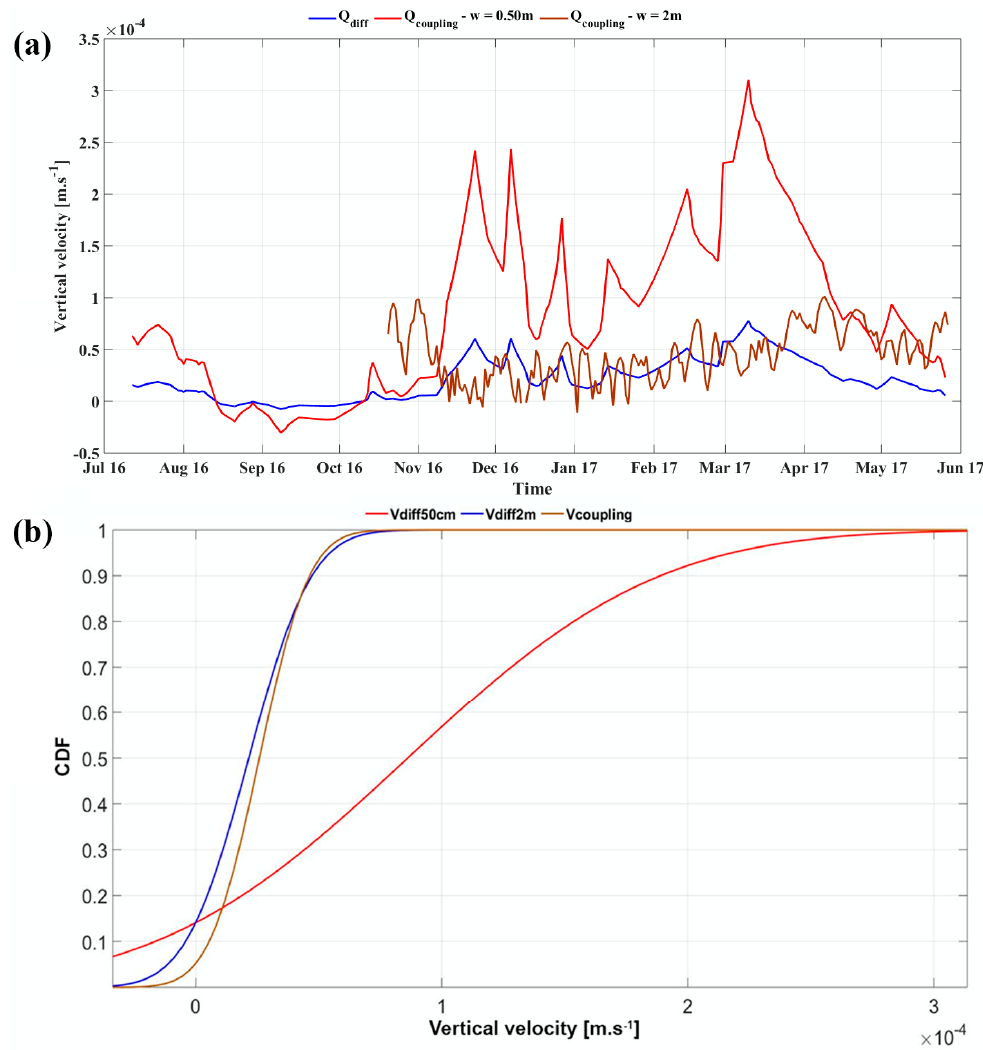
Figure 10. Linear velocities observed from differential gauging (V diff ) normalized using a stream 2 m or 0.5 m wide and mean vertical flow (V coupling ) calculated by coupling fiber optic distributed temperature sensing and thermal lances. ( a ) Dynamics of hyporheic flow over time. ( b ) Cumulative distribution function (CDF) of each hyporheic flow.